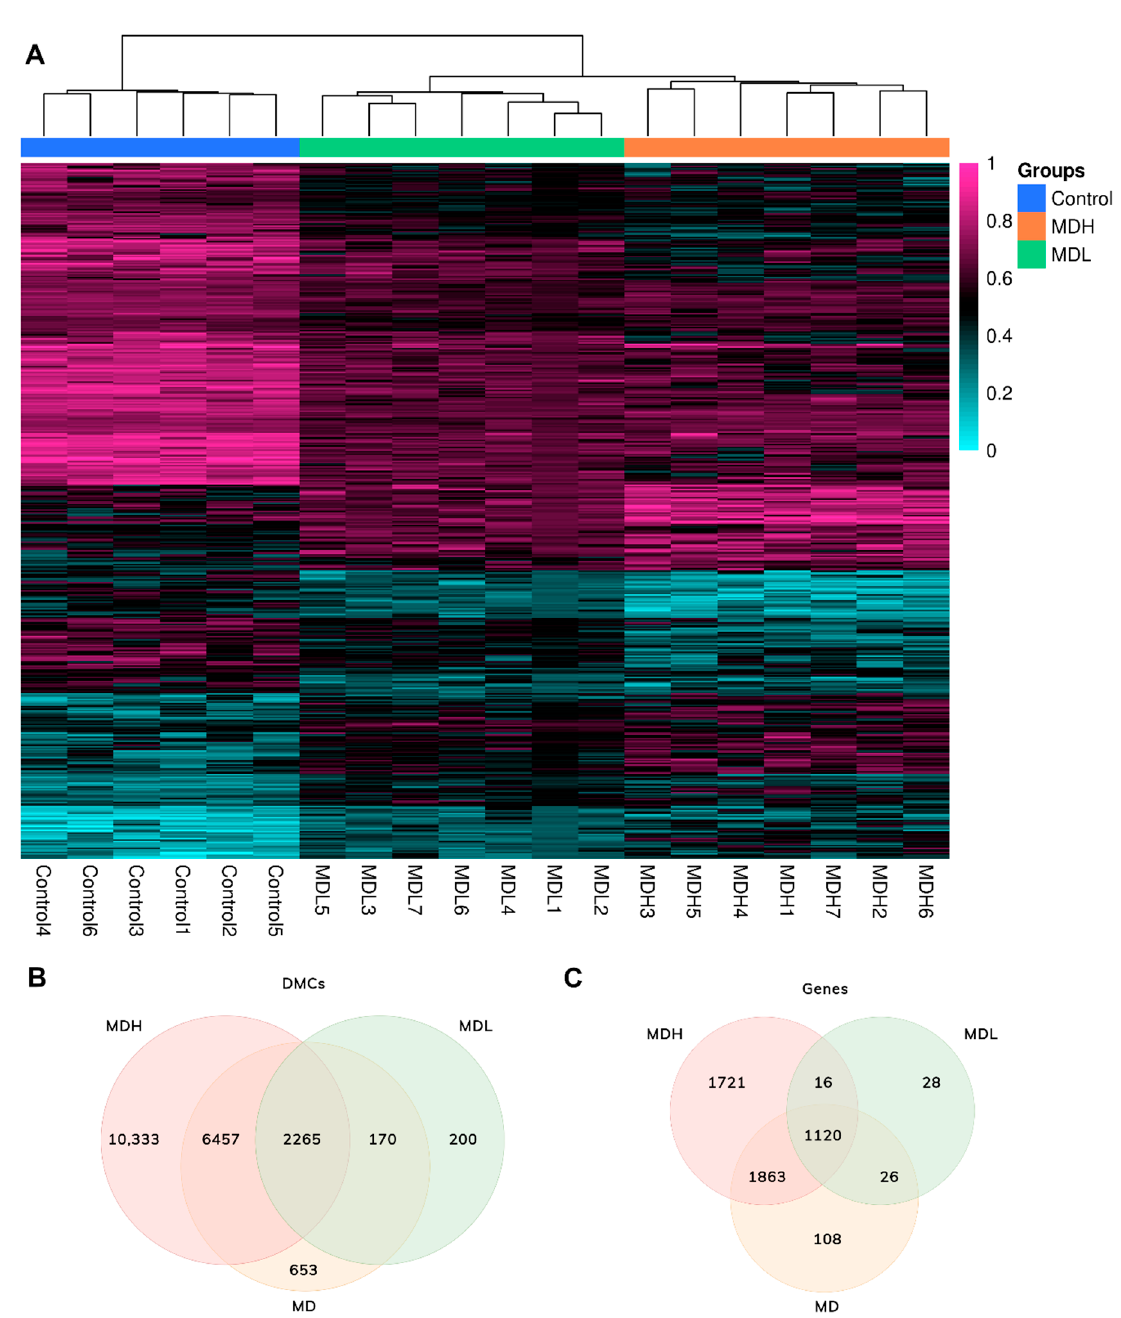
Figure 2. Differentially methylated CpGs and genes in Meniere Disease patients and controls. ( A ) The rows are the methylation ratio (from 0 to 1) of each position and the columns are representative of each individual, which are classified by control, MDH (Meniere Disease High) and MDL (Meniere Disease Low). The positions represented were those with a higher absolute value of the difference in methylation: 150 DMCs (differentially methylated CpGs) that show the difference between Meniere Disease and control (Table S2), 250 DMCs for MDH (Table S3) and 100 DMCs for MDL (Table S4); ( B ) Venn diagram of DMCs (DM > 8%) comparing Meniere Disease to controls (MD), Meniere disease with high levels of cytokines to controls (MDH) and Meniere Disease with low levels of cytokines to controls (MDL); ( C ) Venn diagram of annotated genes from DMC analysis comparing Meniere Disease to controls (MD), Meniere disease with high levels of cytokines to controls (MDH) and Meniere Disease with low levels of cytokines to controls (MDL).